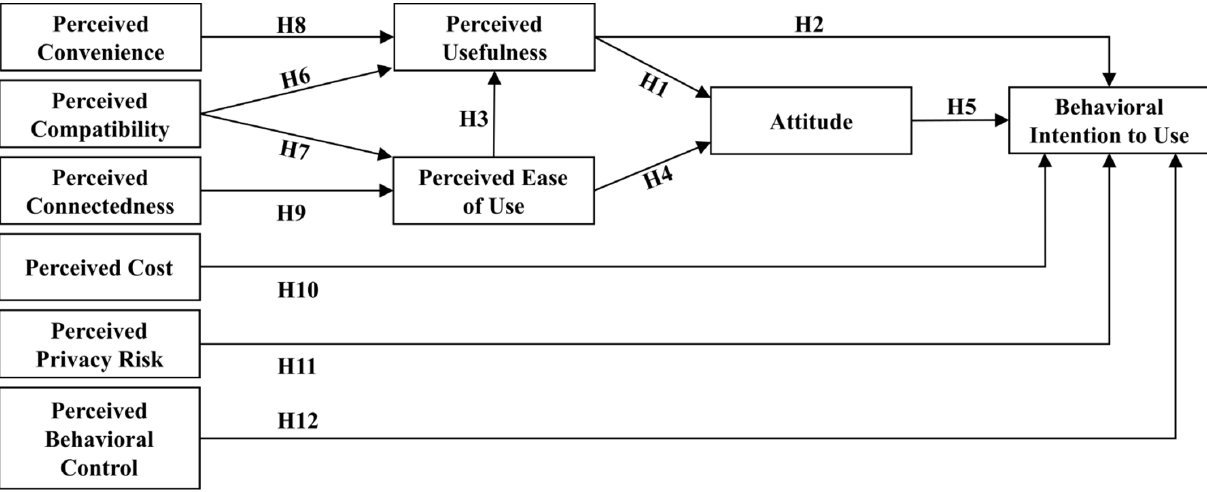
Fig. 1. Research Model and